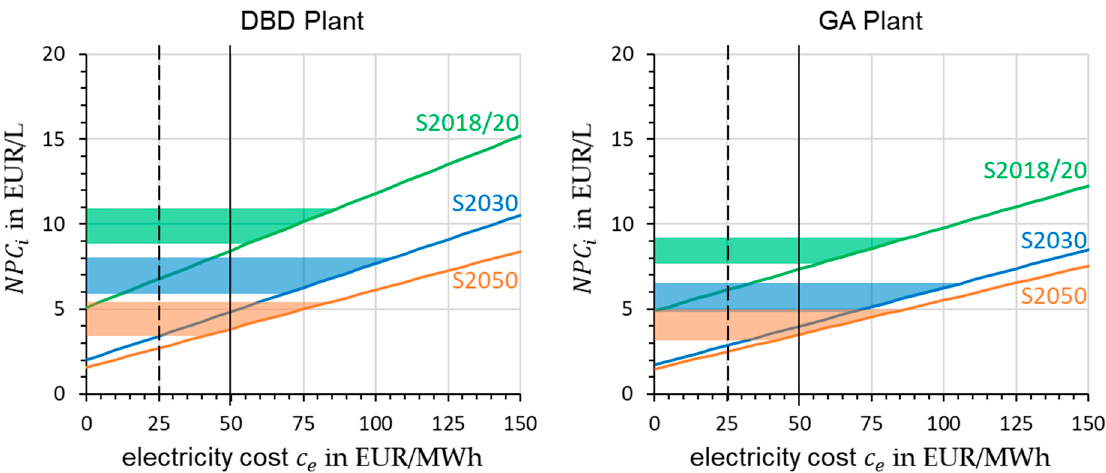
Figure 14. Net production costs (NPC) by varying the electricity cost. The solid vertical line shows the assumption made in the results of the scenarios. The dotted vertical line that of the ICCT scenario described in the text.